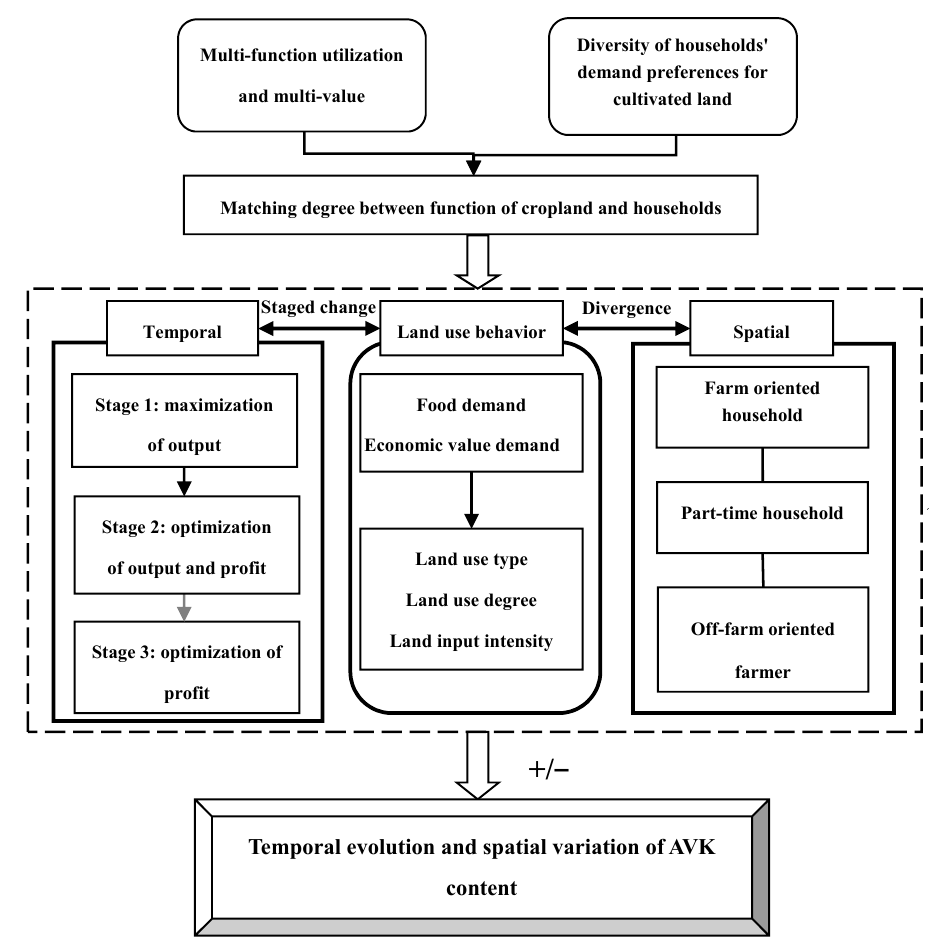
Figure 1. The theoretical analysis framework of the effects of households’ land-use behaviors on soil available potassium (AVK).